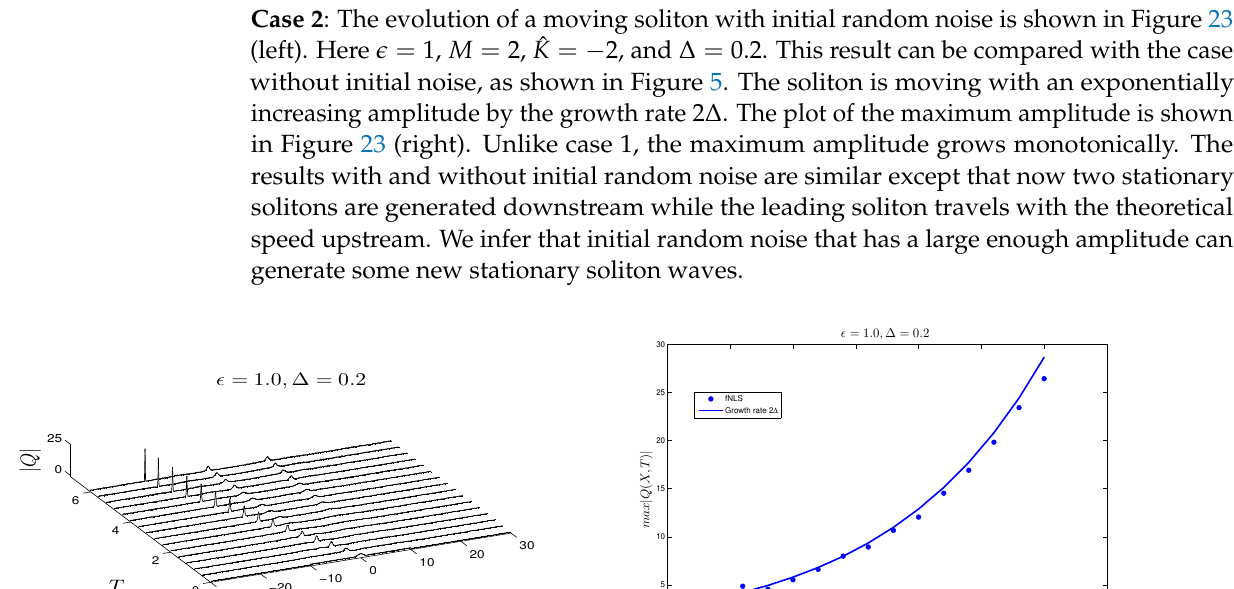
Figure 22. Initial random noise, Case 1: Contour plot of | Q | when ∆ = 0.2 ( left ) and the maximum of | Q ( X , T ) | with the predicted growth rate 2 ∆ ( right ).